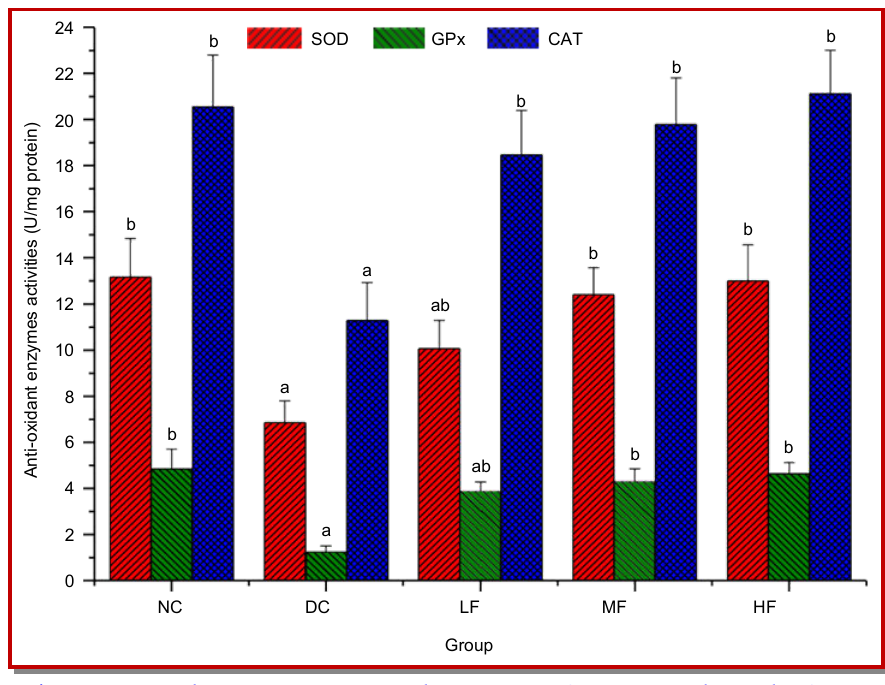
Figure 4: Effects of FTB on anti-oxidant enzymes activities in liver in mice; NC means normal control; DC means diabetic control; Diabetic mice received low dose (LF) , middle dose (MF) and high dose (HF) of FTB